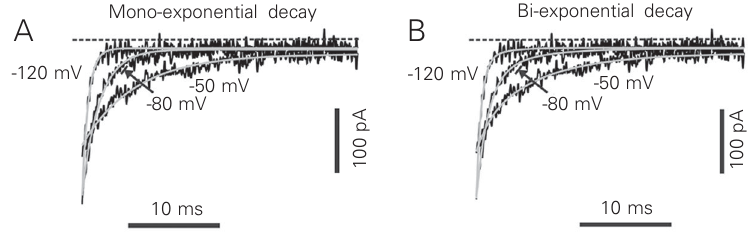
Figure 6. T-type Ca 2+ channel subtypes in rat GH3 cells. RT- PCR performed to identify the presence of mRNA for the α 1G and α 1 I subunits in GH3 cells. The positive control contained primers specific for ß-actin (lane 2). Negative controls did not in- clude RNA or reverse transcrip- tase (RT) in the tubes (lanes 3, 4, 6, 7, 9 and 10).